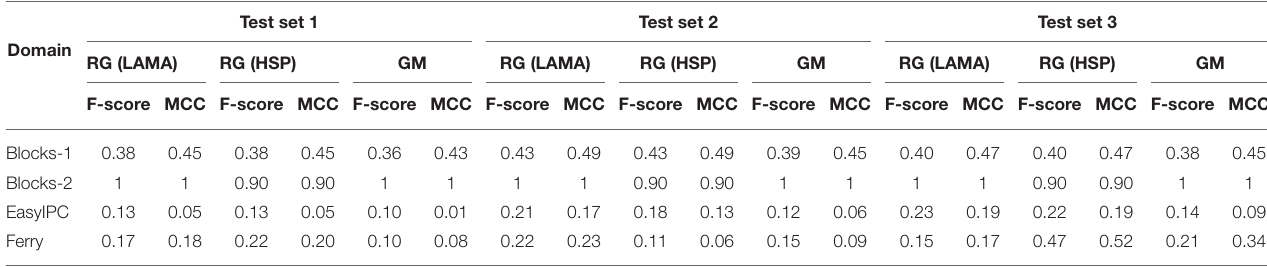
TABLE 5 | F-score and Matthews Correlation Coefficient (MCC) for recognizing intervention using probabilistic goal recognition (RG) algorithm (Ramırez and Geffner,